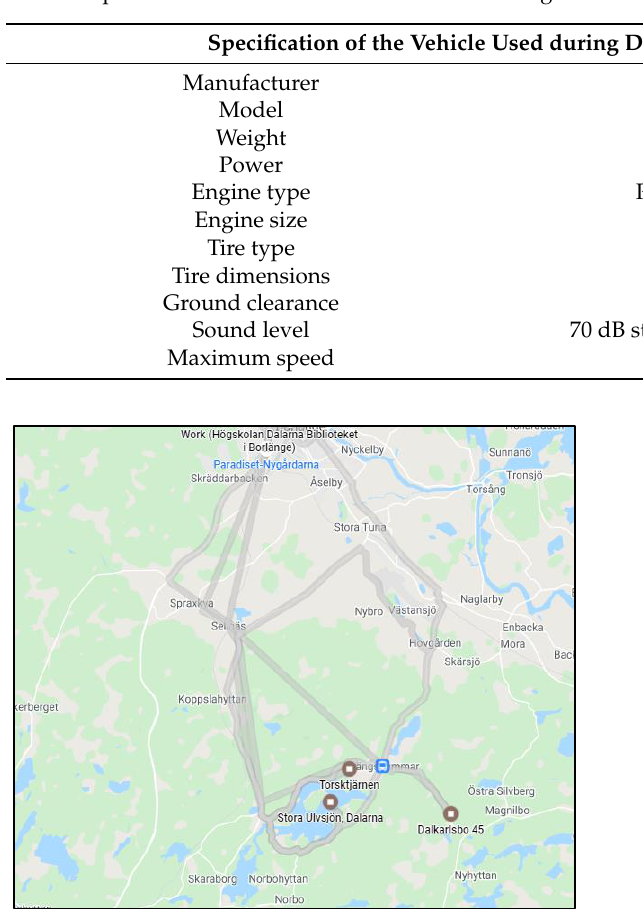
Table 3. Specification details of the vehicle used during data collection.